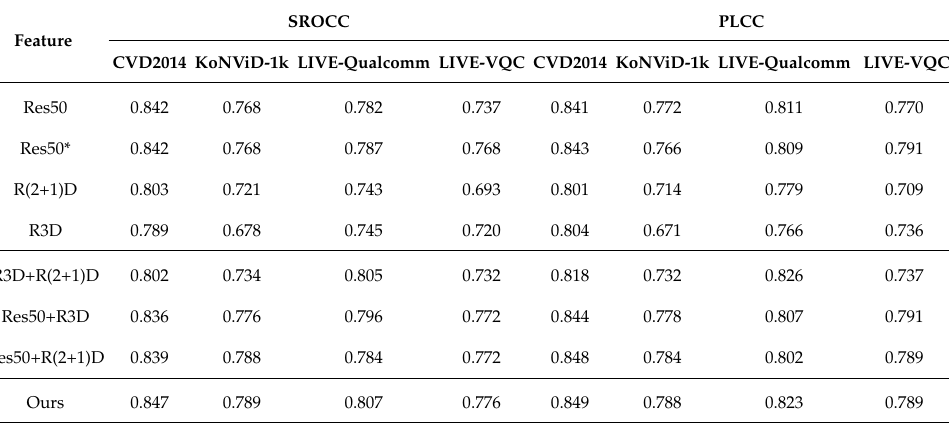
Table 6. Comparison of different input features and their fusions (Res50* refers to the model finetuned in the IQA